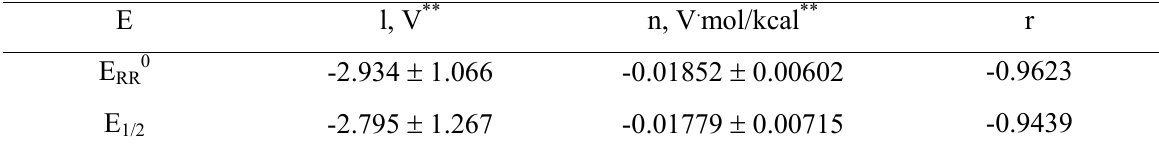
Table 2d. Correlations of standard potentials of reductive dimerization (E RR0 ), semineutralization )( vs saturated Hg potentials (E 1/2